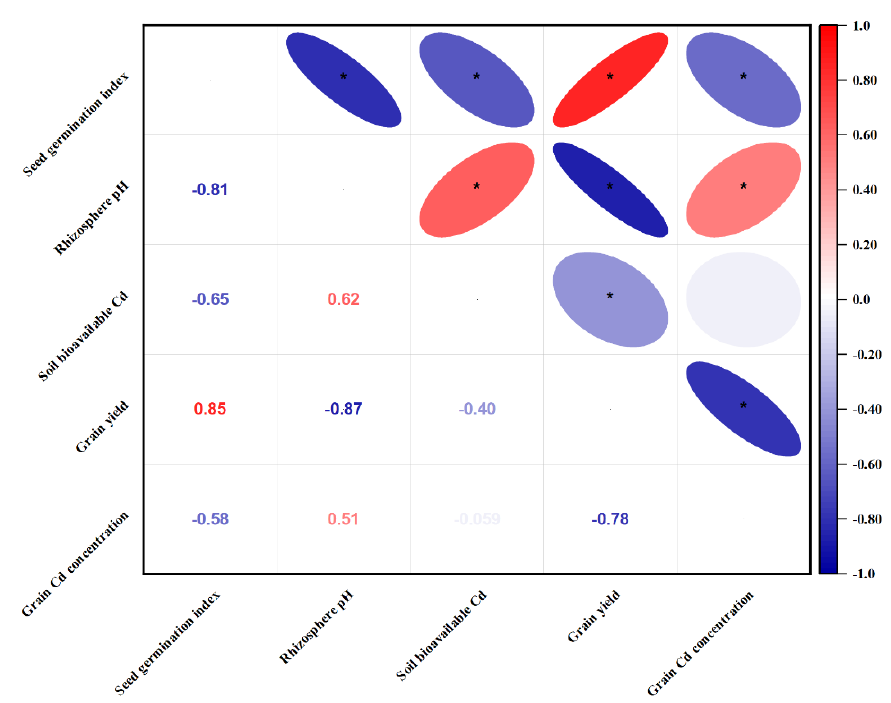
Figure 6. Correlation matrix showing relationships between seed germination index, rhizosphere pH, soil bioavailable Cd, grain yield, and grain Cd concentration under a large-scale field experiment. Red color denotes positive relationships; blue color denotes negative relationships. Left-inclined ellipses denote a positive relationship, right inclined ellipses denote a negative relationship. Asterisks represents significant correlations.